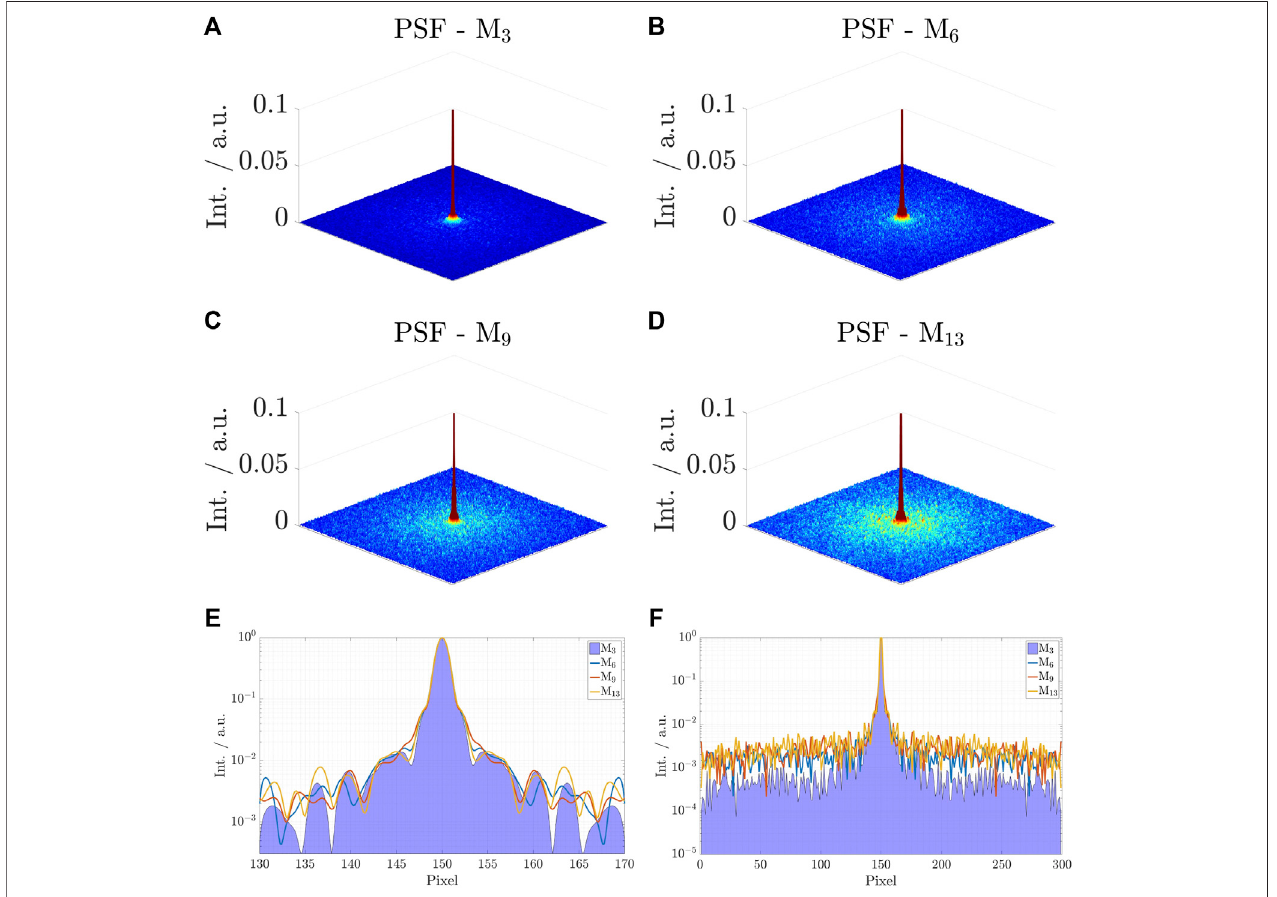
FIGURE 3 | Spectral noise analysis for three different ROIs as indicated in d) for four different undersampling factors (ROI 1: green, ROI 2: red, ROI 3: yellow).